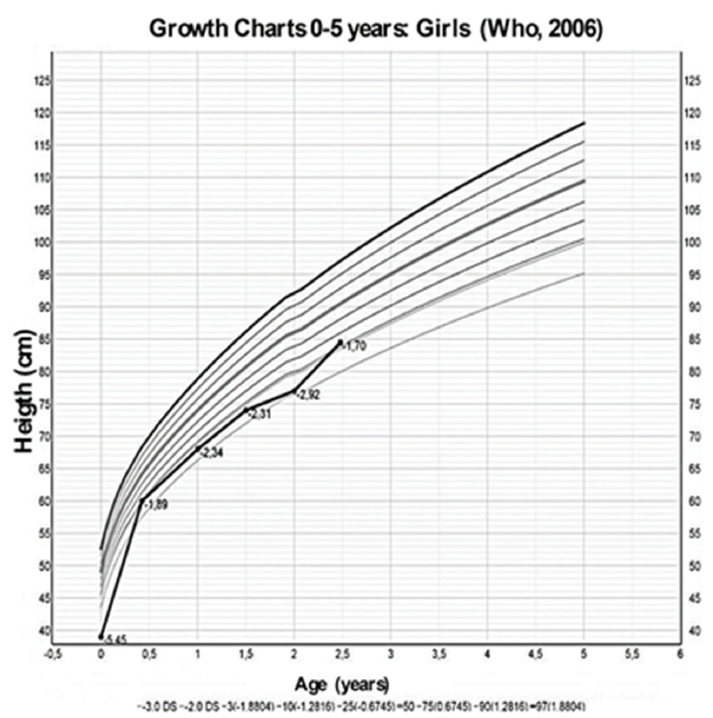
Figure 2. Growth charts, from Who 2006 [13], of the height of the patient at different ages.